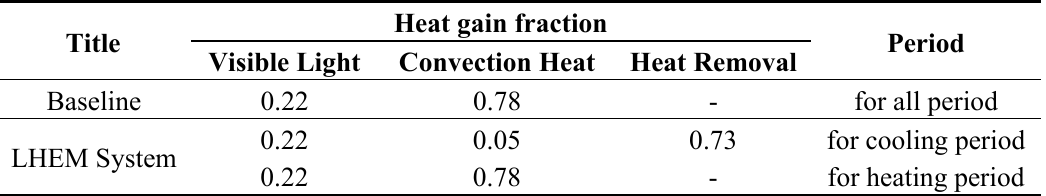
Figure 7. Illustration of the office building model. Table 2. Lighting heat gain fractions for energy simulation